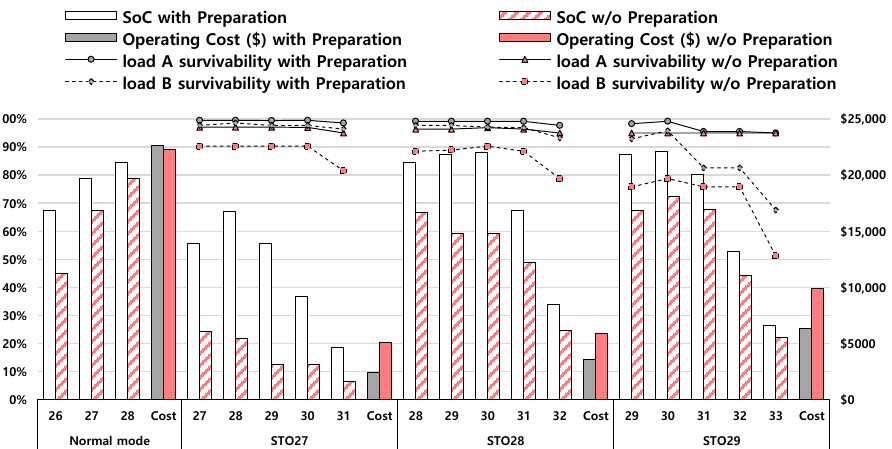
Figure 9. Different components (SoC, load A survivability, load B survivability, and operating costs) of MG operation based on the proactive action at each event period in Case 2.